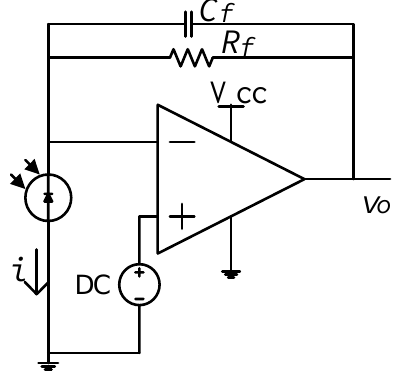
Figure 3. Schematic diagram of the detection circuit.